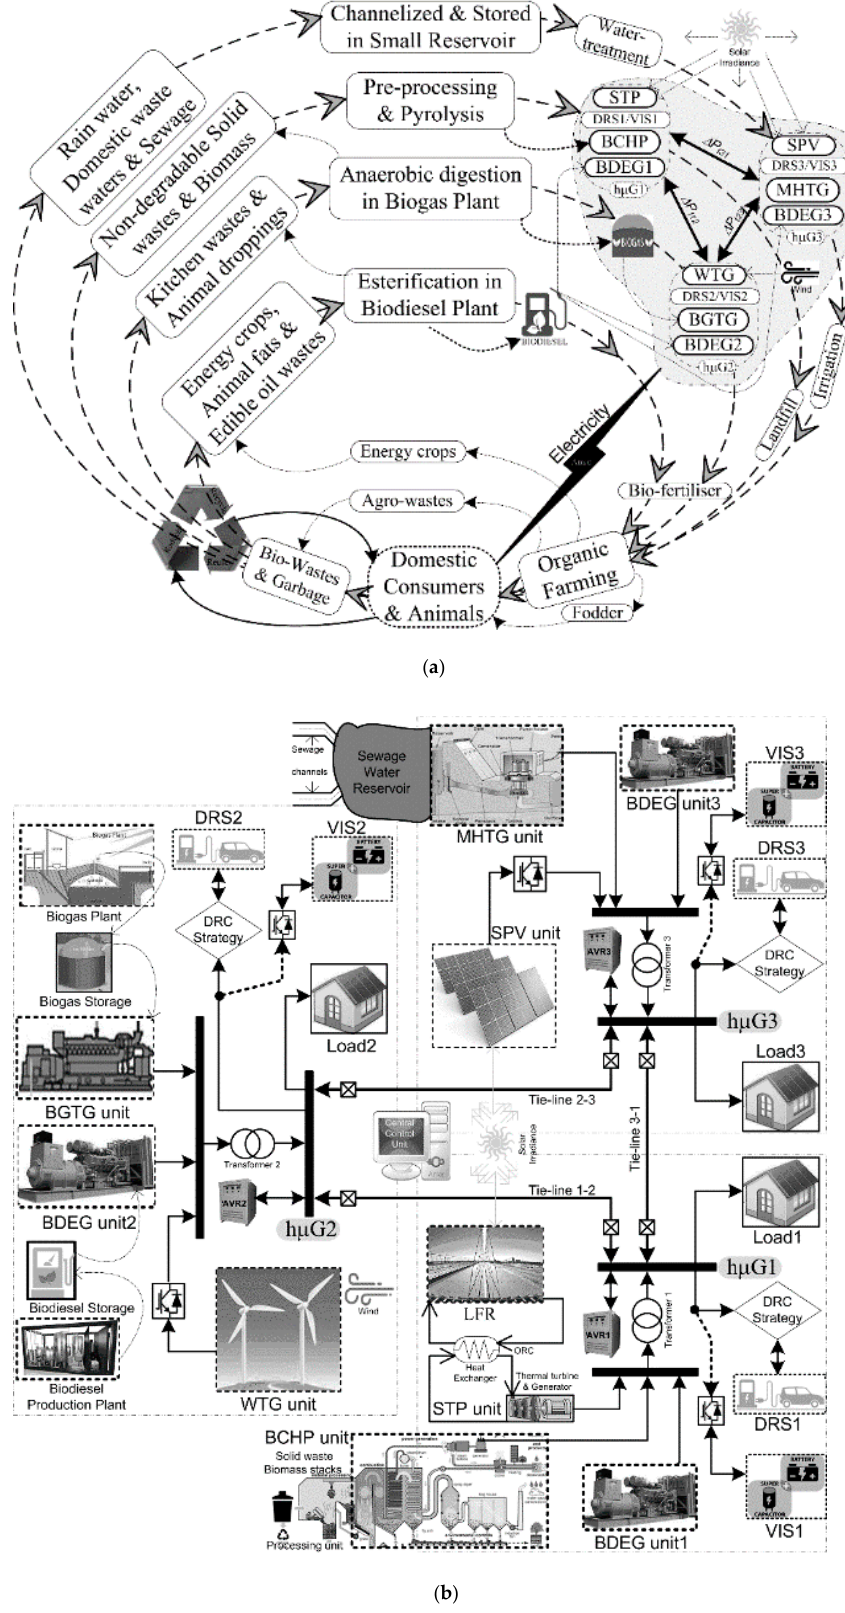
Figure 2. ( a ) Waste-to-energy cycle allied to distribution of microgrids and ( b ) schematics of the proposed interconnected microgrids.